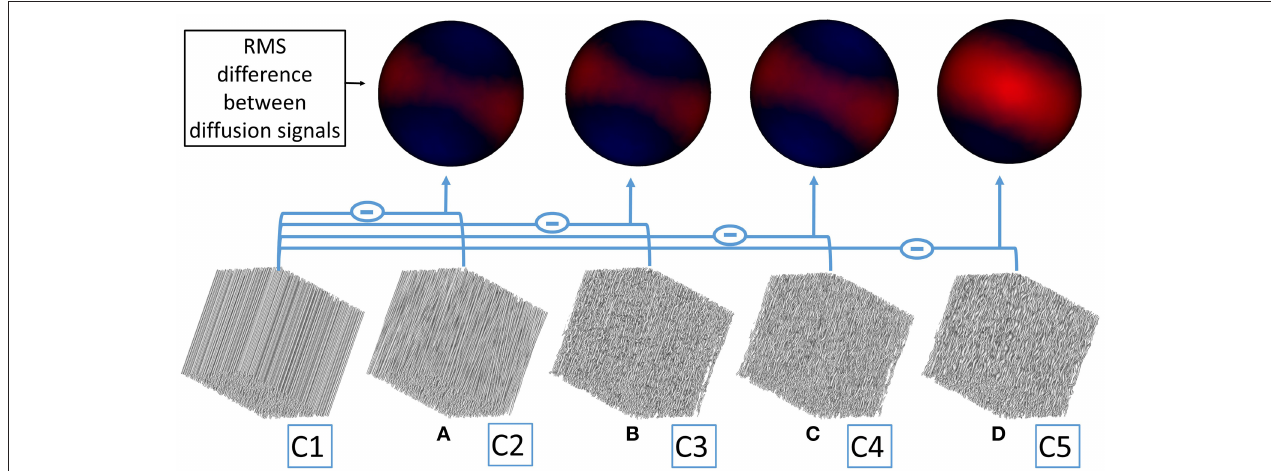
FIGURE 7 | From left to right, simulation domains corresponding to different geometrical configurations (from C1 to C5) are shown. A 3D rendering of the root-mean-squared difference (represented by the minus sign) between the diffusion signal stemming from each configuration and the “reference” configuration C1 (most left configuration composed of straight parallel cylinders) is shown on a spherical surface. (A) The RMS signal difference is computed between configuration C1 and C2. The red area where the diffusion signal difference is the strongest corresponds to diffusion sensitization directions perpendicular to fibers. Blue areas correspond to directions parallel to fibers where the signal differences are weaker but not null, and originate from the variations of diffusion properties around those directions when structural disorder is added. (B–D) Represent the same RMS signal differences between configurations C1 and C3, C1 and C4 R 4 (corresponding to configuration C4 with a demyelination ratio of 25 % , see Table 2 ), C1 and C5, respectively.